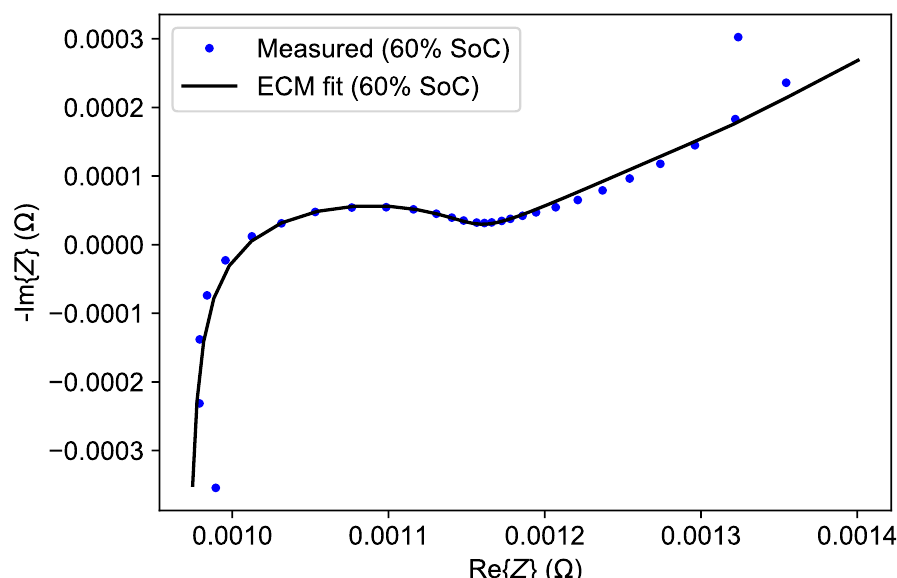
Figure 4. Nyquist plot of fit to modification of the equivalent circuit shown in Figure 3 with experimental impedance data obtained at 60% SoC, 25 ◦ C, frequency range 1 KHz–15 mHz over the red and white terminals of module 1 of 13, and capacity 54.9 Ah.